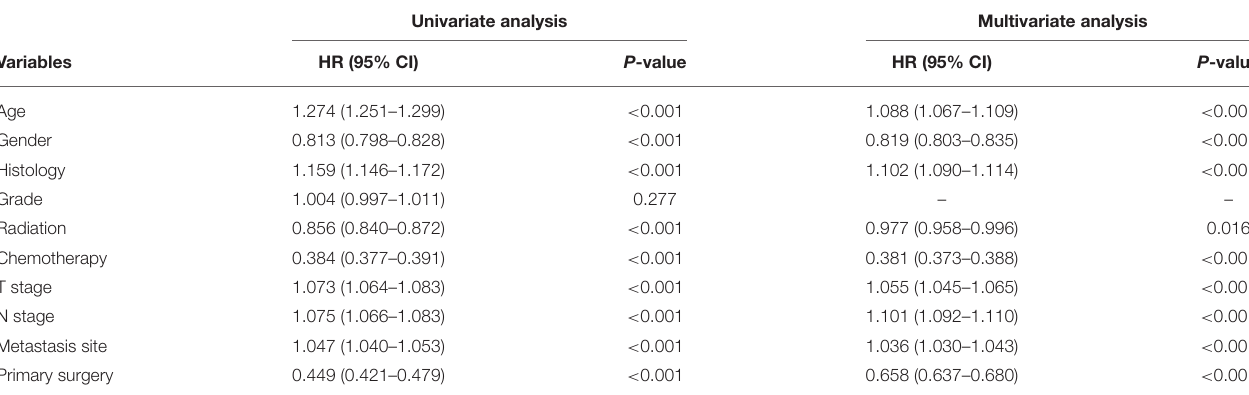
TABLE 2 | Univariate and multivariate analysis between clinicopathological characteristics for LCSS of all patients. Univariate analysis Multivariate analysis